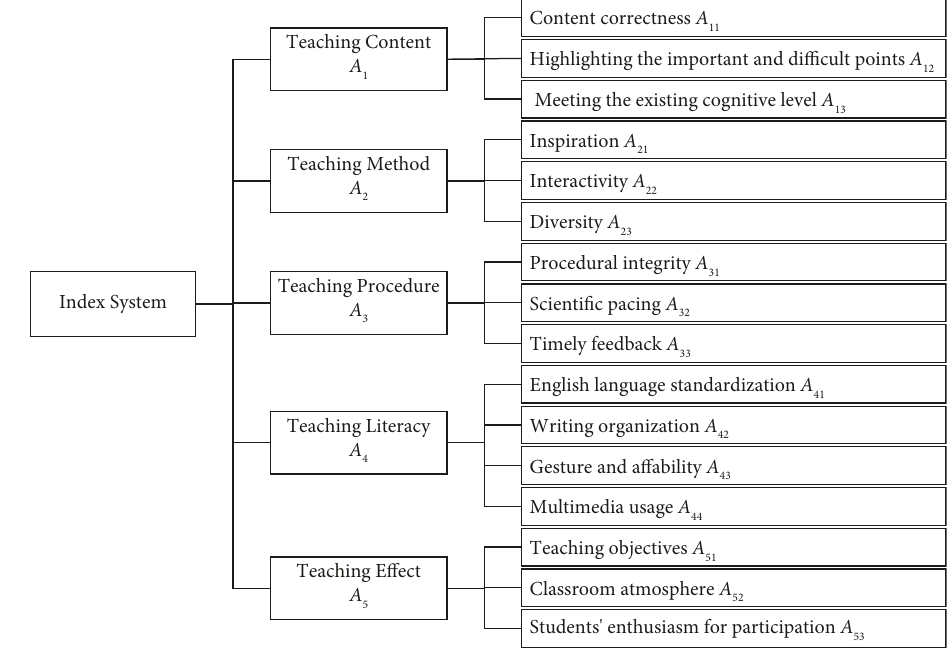
Figure 1: Evaluation index system of